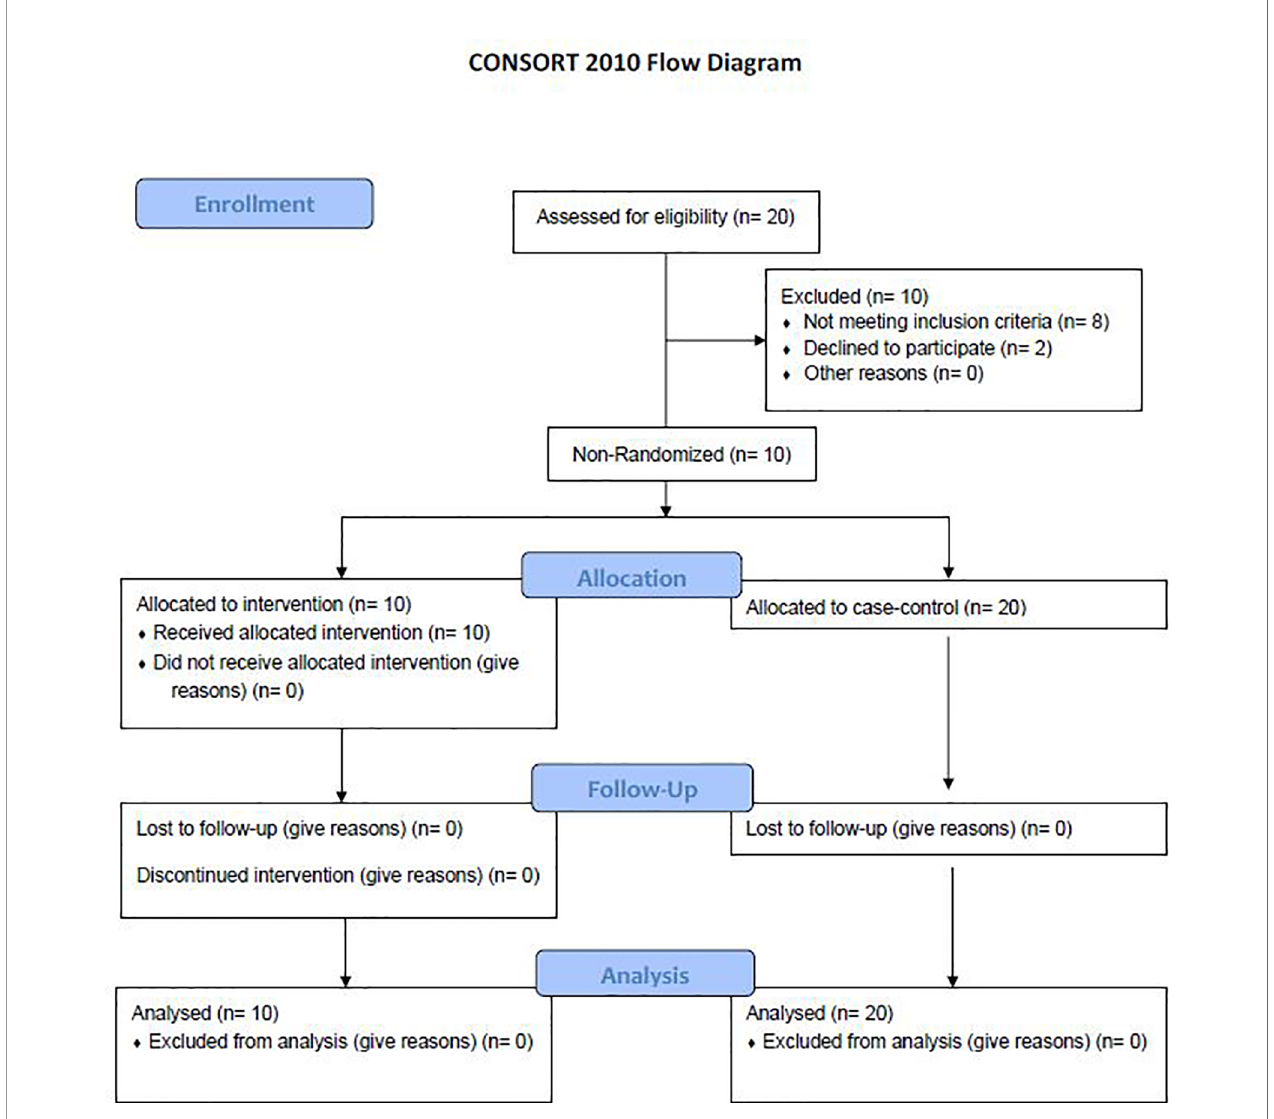
FIGURE 1 | Consort fl ow diagram. A total of 20 patients were evaluated for the study with 8 patients not meeting inclusion criteria and 2 declining to participate. 10 patients were included in the treatment arm with no patients lost to follow up. 20 patients were randomly selected to be a part of the case-control arm